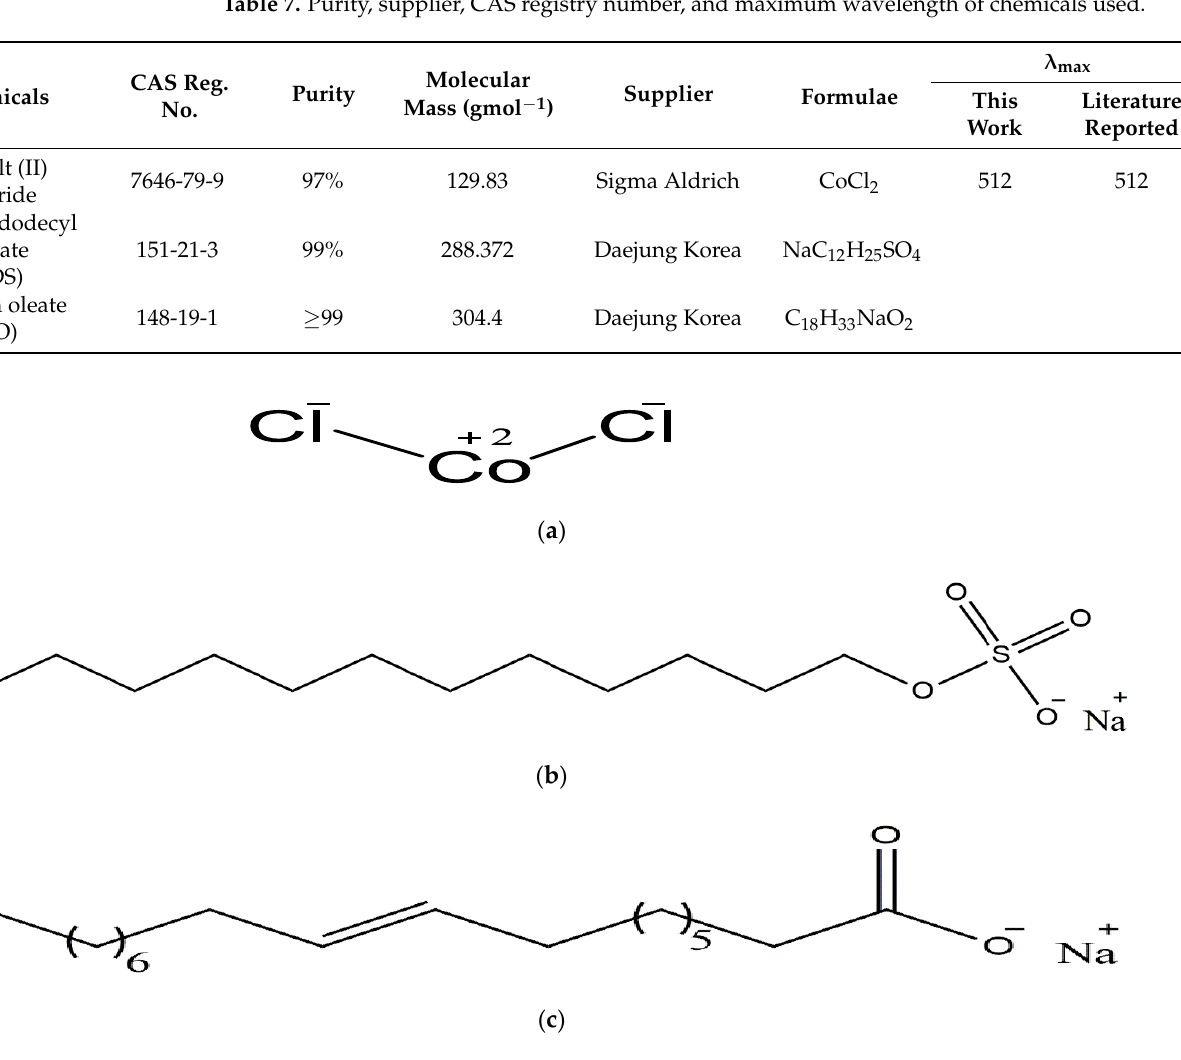
Scheme 4. Structures of metal and surfactants, ( a ) cobalt chloride (II), ( b ) sodium dodecyl sulfate (SDS), ( c ) sodium oleate